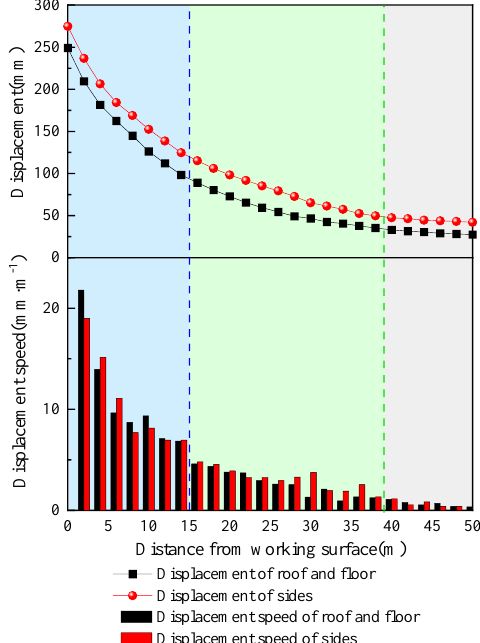
Figure 22. Roadway surface displacement curve.